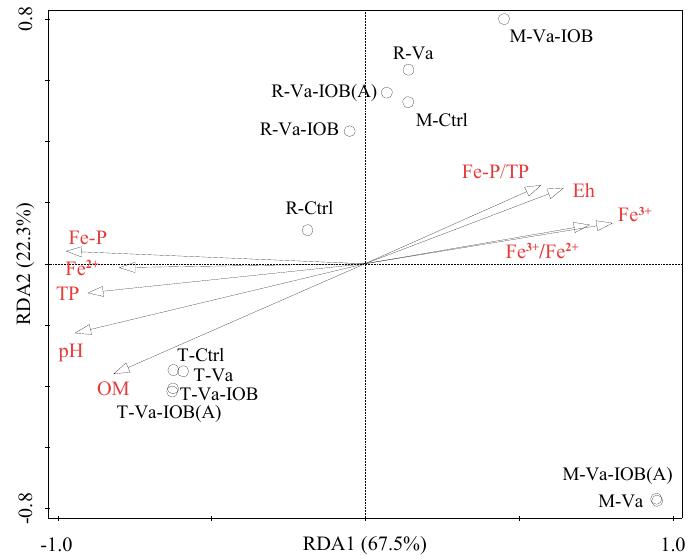
Figure 5. Redundancy analysis (RDA) ordination bi-plot showing the relationships between bacterial community structure (phylum level) and sediment environmental variables. OM, organic matter; Eh, redox potential; TP, total phosphorus; Fe–P, iron-bound phosphorus. Black circles represent treatments at different V. natans growth stages: T, transplanting; R, rapid growth; M, mature.